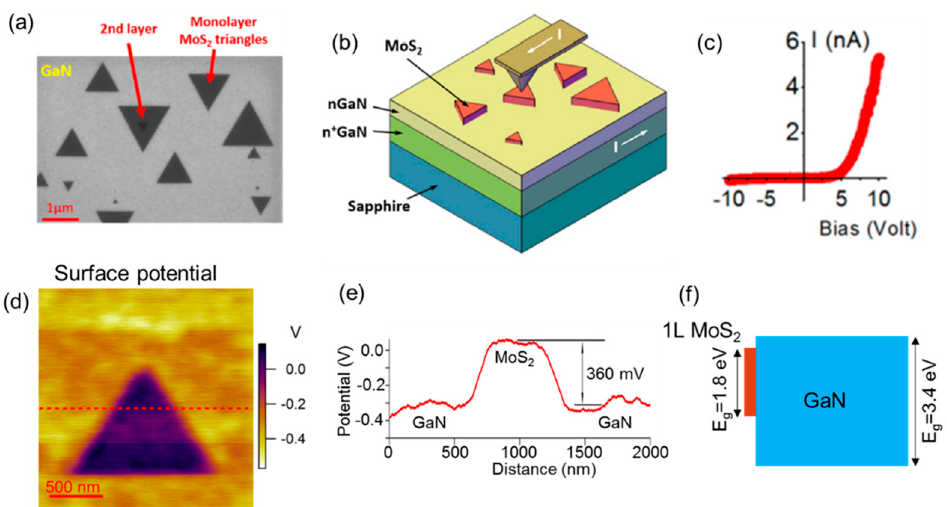
Figure 11. ( a ) SEM image of triangular domains of epitaxial monolayer MoS 2 grown by CVD on GaN. ( b ) Schematic of the C-AFM setup for local I-V analyses on the MoS 2 /GaN junction. ( c ) Current-voltage characteristic on an individual MoS 2 domain. ( d ) Surface potential map measured by KPFM on a monolayer (1L) MoS 2 domain on GaN and ( e ) potential line-scan along the dashed line in the map, showing a 360-mV surface potential difference between 1L MoS 2 and GaN. ( f ) Energy band alignment at the 1L MoS 2 /GaN interface, as deduced from the surface potential map. Images adapted with permission from Reference [19], copyright from the American Chemical Society 2016.